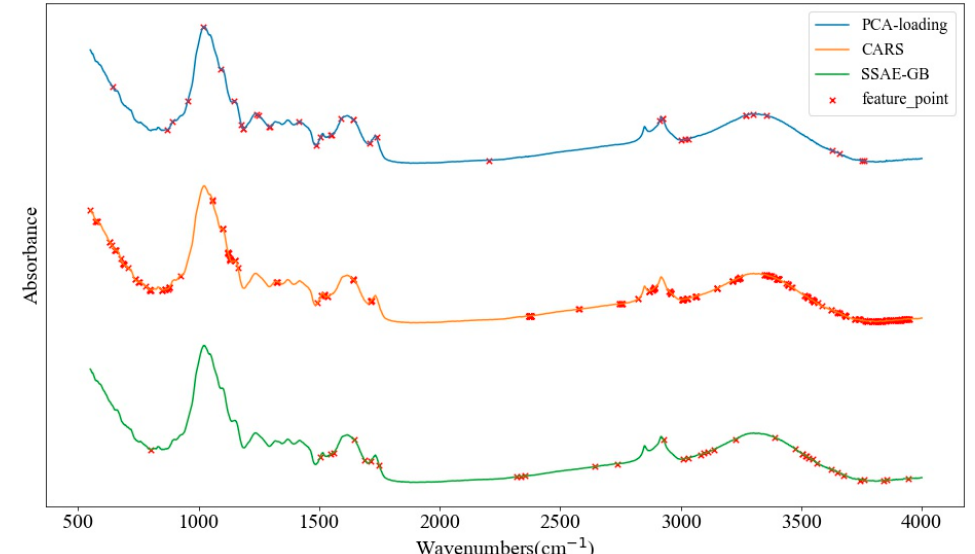
Figure 4. The distribution of optimal wavenumbers selected principal component analysis loading (PCA-loading), competitive adaptive reweighted sampling (CARS), and SSAE-GB.